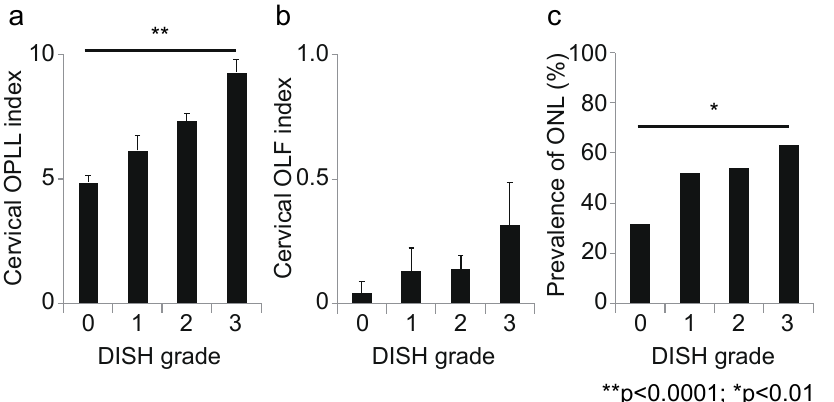
Figure 3. Correlation between DISH grade and OSL at the cervical spine. ( a ) Cervical OPLL index; ( b ) cervical OLF index; ( c ) prevalence of ONL. DISH, diffuse idiopathic skeletal hyperostosis; OLF, ossification of the ligamentum flavum; ONL, ossification of the nuchal ligament; OPLL, ossification of the posterior longitudinal ligament; OSL, ossification of the spinal ligaments.